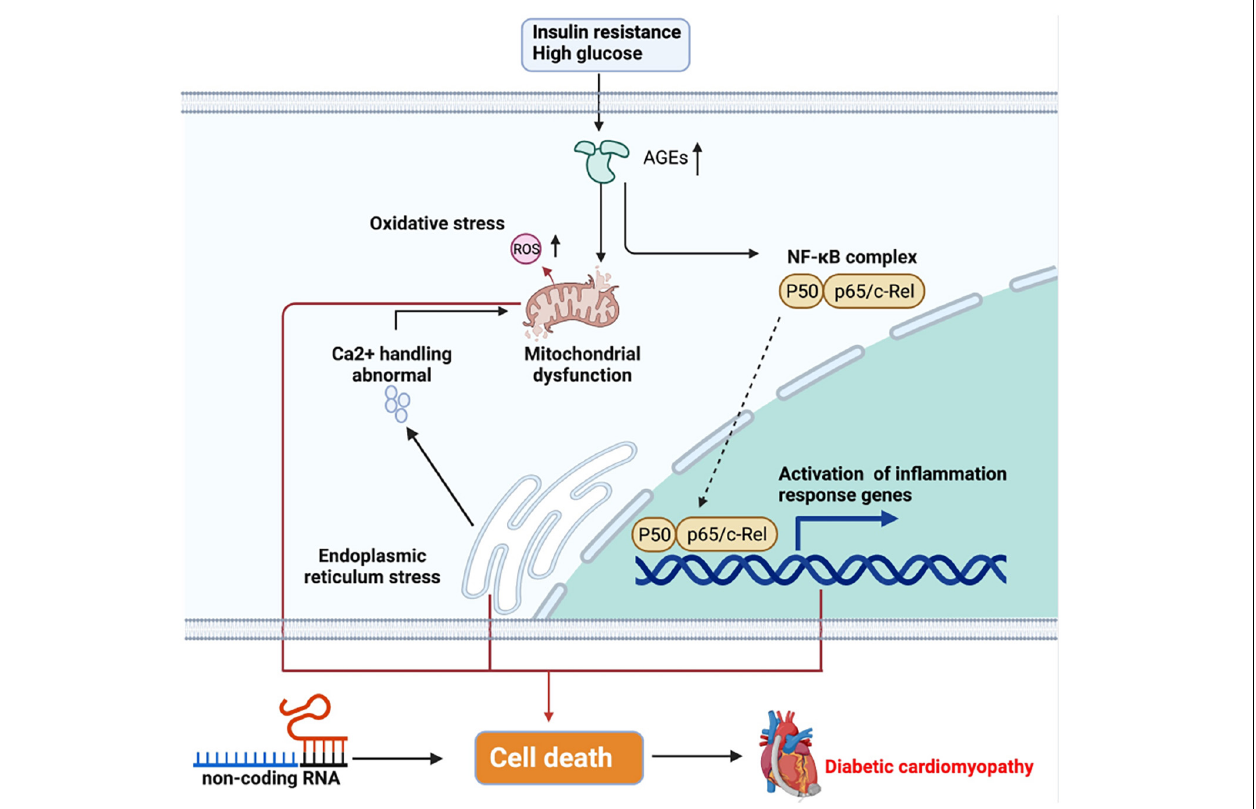
FIGURE 1 | Pathogenesis of diabetic cardiomyopathy (DbCM). Insulin resistance and high glucose trigger cell metabolism disorder, further causing inflammation and cell death, which finally results in heart failure. ER, endoplasmic reticulum; AGEs, advanced glycated end-products; ROS, reactive oxygen species; NF- κ B, nuclear factor- κ